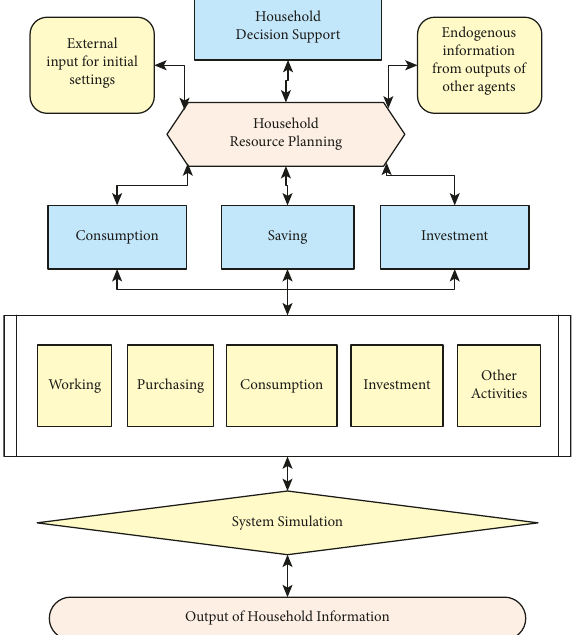
Figure 3: Overview of the process and structure of resident system (source: Guangzhou Milestone Software Co., Ltd.,